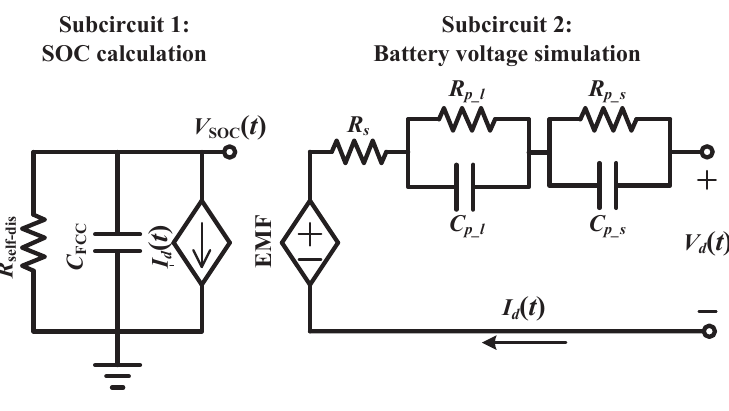
Figure 1. Second-order equivalent circuit model